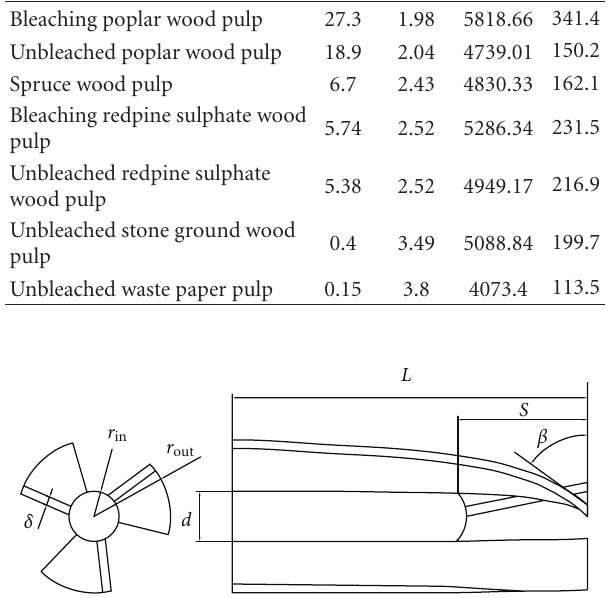
Figure 2: Turbulence generator. r out is the blade outlet radius; r in is the blade inlet radius; d is the hub diameter; δ is the blade thickness; β is the blade laying angle; S is the blade overhang length; L is the blade total